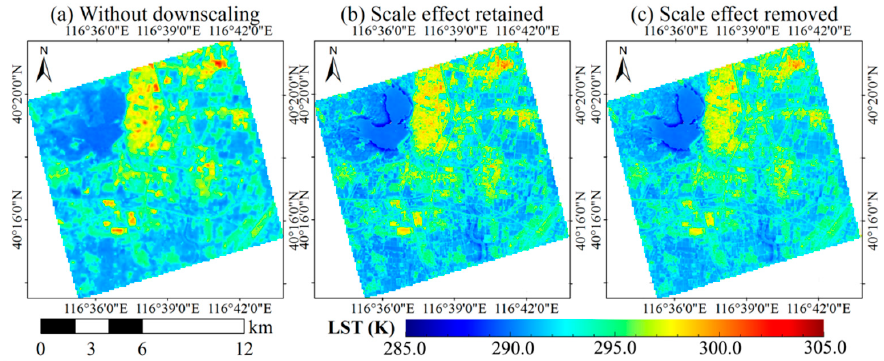
Figure 13. ( a ) TIRS LST at 100 m and ( b , c ) LSTs downscaled from 100 m to 30 m with GRM in Case A in Beijing city on 31 July 2013. Surface temperatures of the lake were downscaled by uniform disaggregation.